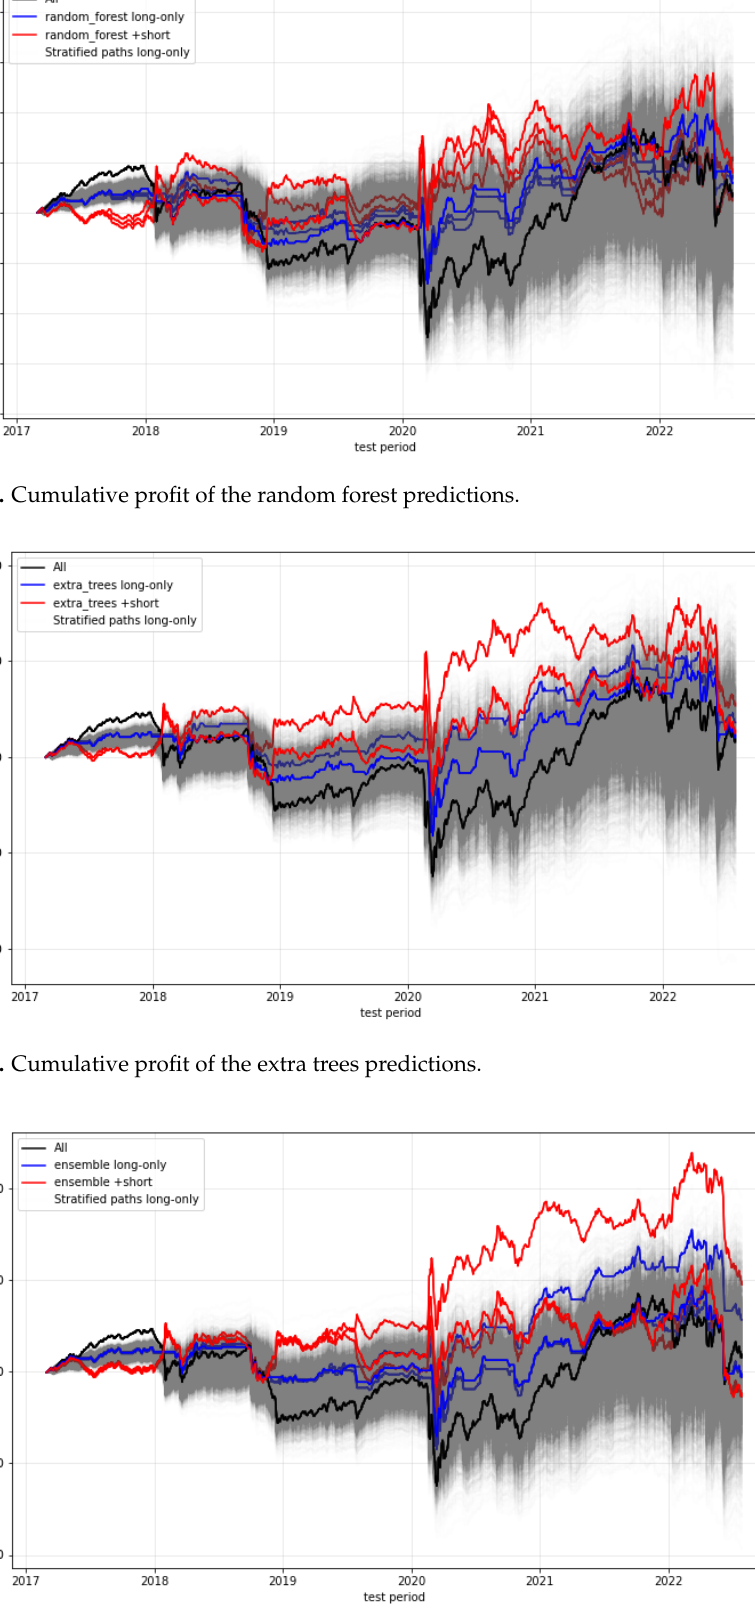
Figure 9. Cumulative profit of the ensemble